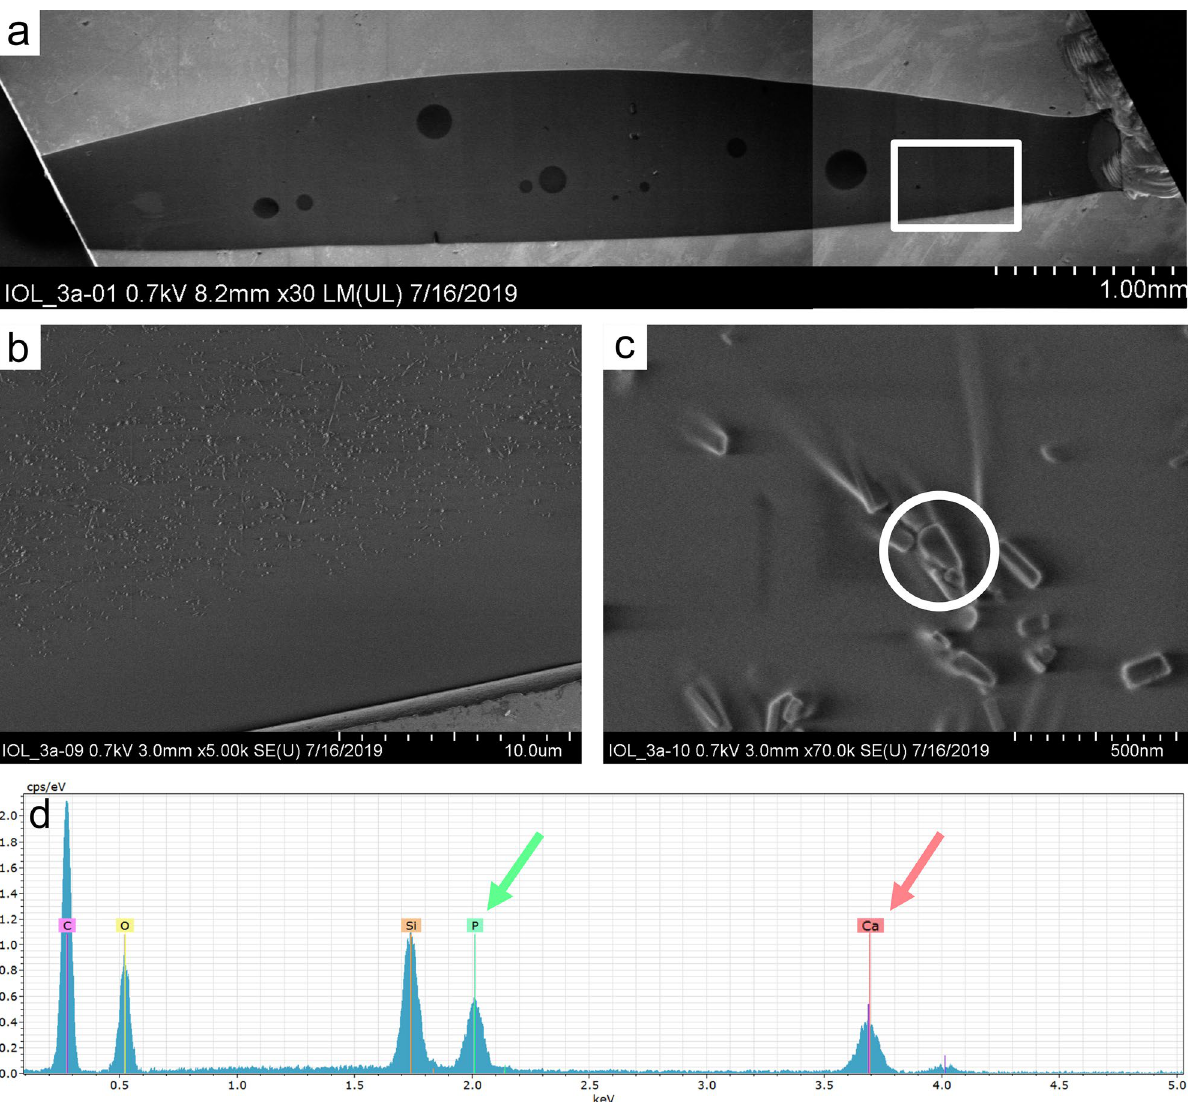
Figure 5. Chemical analysis of the crystals formed within the polymer of IOL 3a. Scanning electron microscopy investigation of a vertical section ( a ) overview, ( b , c ) higher magnification) with energy dispersive X-ray spectroscopy ( d ) confirms the crystals to consist of calcium (Ca) and phosphorus (P). The silicon peak (Si) originates from the silicon waver, carbon (C) and oxygen (O) peaks from the IOL